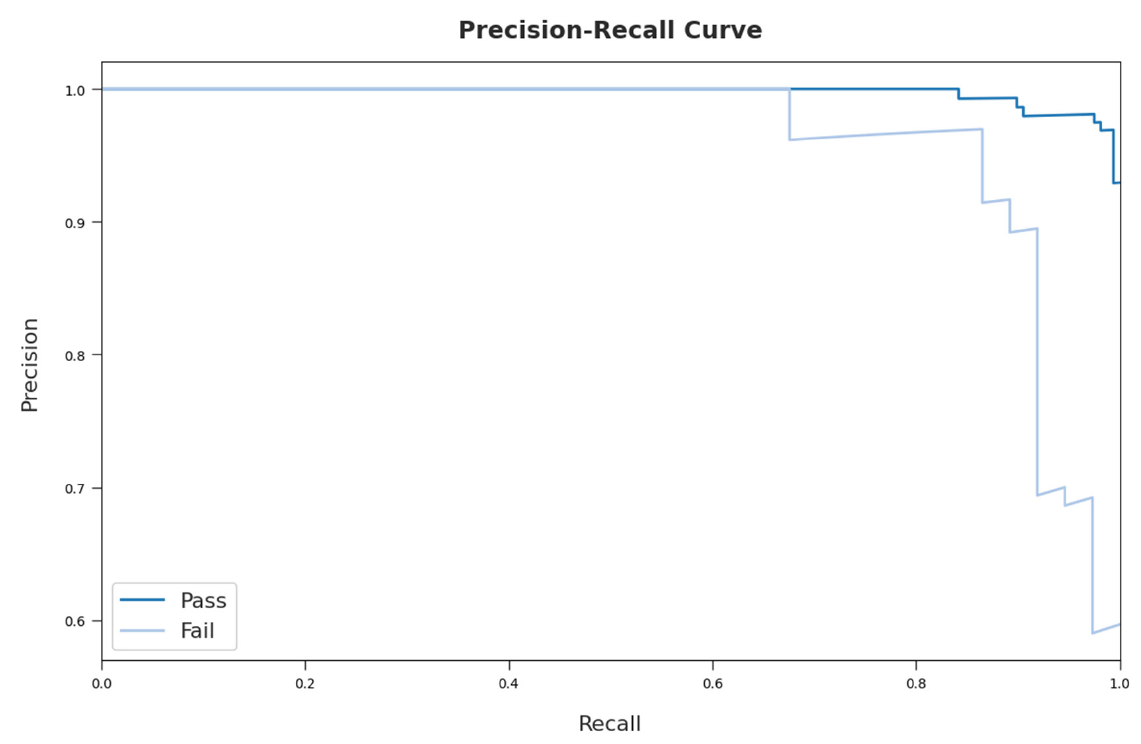
Figure 9. Precision-recall curve analysis of FSSML-EDM technique.